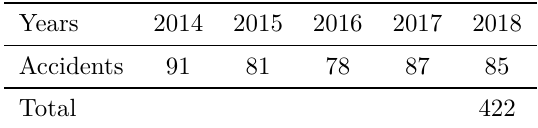
Table 1. Total number of